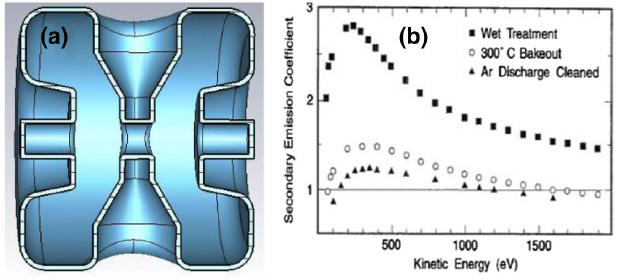
FIG. 23. (a) The shelled model for the SSR cavity and (b) the SEY plot for the three Niobium types that can be used to perform the multipacting simulations.